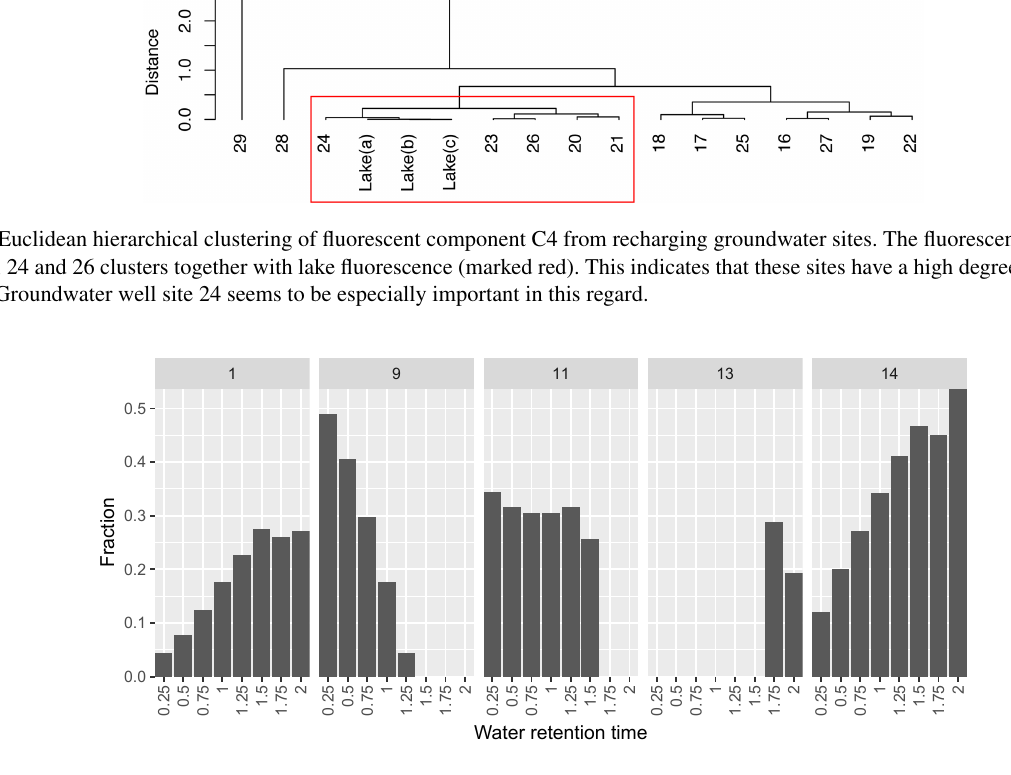
Figure 6. Results derived from the CATS model shown in a bar plot in which the groundwater well sites (their numbering) are seen on the top x axis and the fractions of groundwater discharge estimated to derive from the sites are shown on the y axis (only the sites that deliver more than 0.1% water to the lake are shown). The bottom x axis denotes the different water retention times used in this model. Three to four sites generally explain the estimated concentrations in the